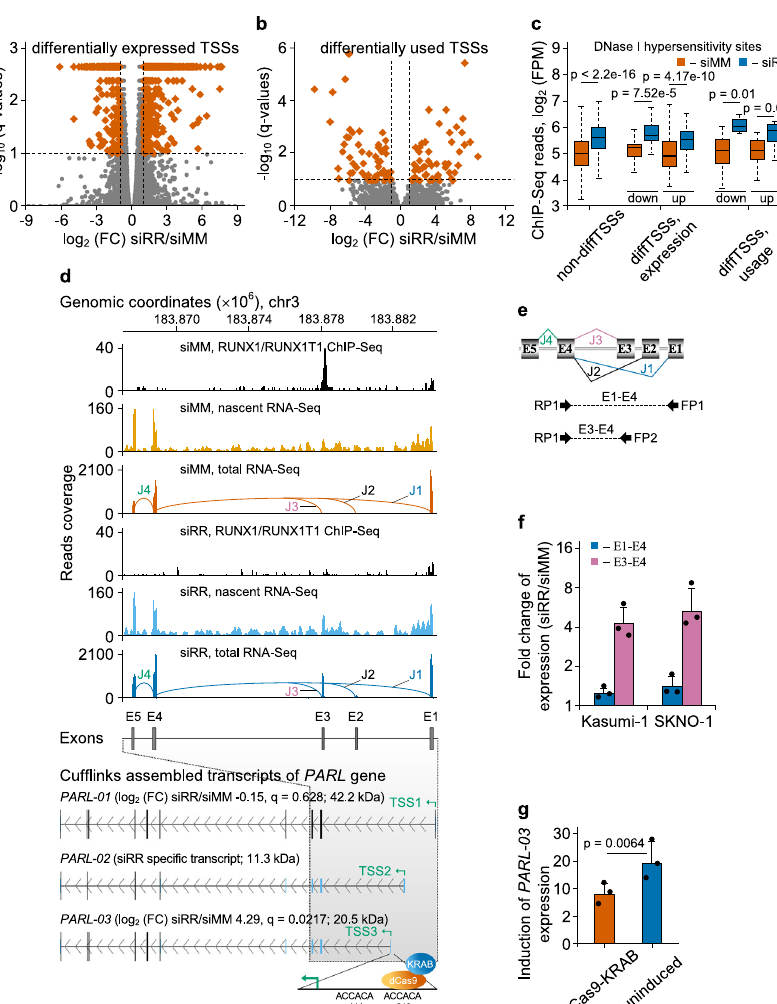
Fig. 7 RUNX1/RUNX1T1 affects differential splicing by controlling alternative transcription start sites (TSSs). a Vulcano plot of the differential expression from various TSSs in the genome of Kasumi-1 cells following RUNX1/RUNX1T1 knockdown. Differentially expressed TSSs (at least 2-fold change in expression, p < 0.005, q < 0.1) are shown by vermilion squares. b Differential usage of alternative TSSs in the genome of Kasumi-1 cells after RUNX1/ RUNX1T1 knockdown. Differentially used TSSs (at least 2-fold change in expression, p < 0.0007, q < 0.1) are shown by vermilion squares. c Enrichment of DNase I hypersensitivity site-Seq reads in the genomic regions surrounding the non-differential TSSs, differentially expressed TSSs or differentially used TSSs. In this analysis, only TSSs genomic regions that overlap the RUNX1/RUNX1T1 binding peaks were used. In each boxplot, horizontal line represents the median of expression distribution, box shows the interquartile range, and whiskers are the minimum and maximum. P -values were calculated with two-sided Mann – Whitney U test. d IGV screen shot showing the RUNX1/RUNX1T1 binding and RNA reads from nascent and total RNA-Seq at the 5 ’ -terminal region of PARL locus for siMM-treated and siRR-treated Kasumi-1 cells. Exons and exon-exon junctions are designated by the letters E and J, respectively, and numbered. Differentially used junction J3 is highlighted in purple. Bottom scheme depicting Cuf fl inks assembled representative full-length transcripts of PARL gene expressed in Kasumi-1 cells. For each transcript, Cuffdiff based log 2 (FC) siRR/siMM and q -values, as well as the size of in silico predicted proteins are indicated in parentheses. In addition, the positions of the Cuffdiff determined transcription start sites are also shown. At the bottom of panel, the scheme showing target location of dCas9-KRAB which was targeted to the second RUNX1 consensus site. e Schematic representation of primer binding positions for qPCR-based validation of the differential splicing in PARL gene. The structure of expected amplicons is shown at the bottom of the fi gure. f qPCR-based validation of the differential splicing of PARL transcripts under the two siRNA treatment conditions in the transcriptome of two t(8;21)-positive cell lines. Bars represent mean ± SD of three independent experiments. g Induction of PARL-03 transcription after RUNX1/RUNX1T1 knockdown with or without induction of dCas9-KRAB. Bars represent mean ±SD of three independent experiments. P -value was calculated with two-sided Student ’ s t we hypothesized that differential splicing events can arise from the selection of alternative TSSs under the control of the fusion protein. Indeed, we identi fi ed 775 TSS associated with differential transcription (more than 2-fold change, q < 0.1) in the genome of (Fig. 7a). Among those, knockdown of the RUNX1/RUNX1T1 led to differential usage of 112 alternative TSSs (more than 2-fold change, q < 0.1) (Fig. 7b). Loss of RUNX1/RUNX1T1 increased chromatin accessibility and RUNX1 occupation at alternative